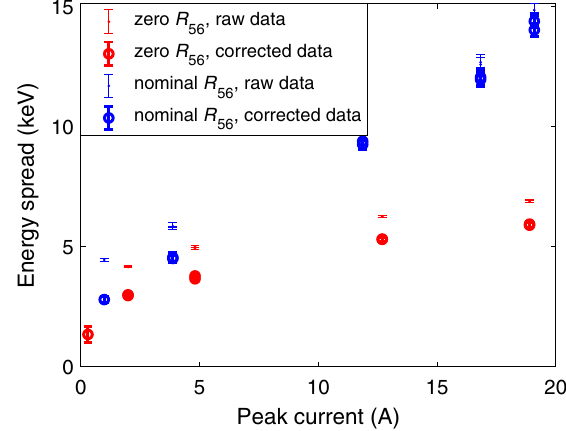
FIG. 3. Measured energy spread as a function of the laser heater and bunch compressor longitudinal dispersion ( R 56 ; and R 56 ; ). BC